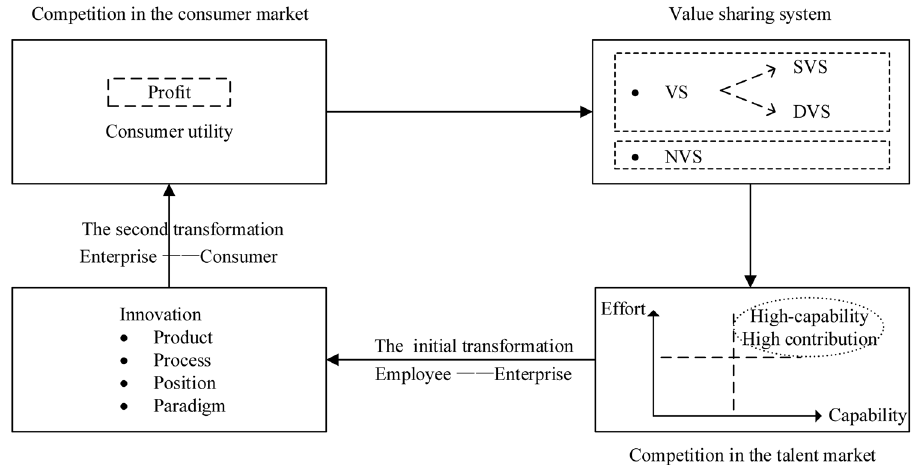
Fig. 2 The interactive in fl uence of enterprise incentive, talent, and market competition strategy. Enterprises take value-sharing mechanisms as a competitiveness-enhancing device to compete in both the talent market and the consumer